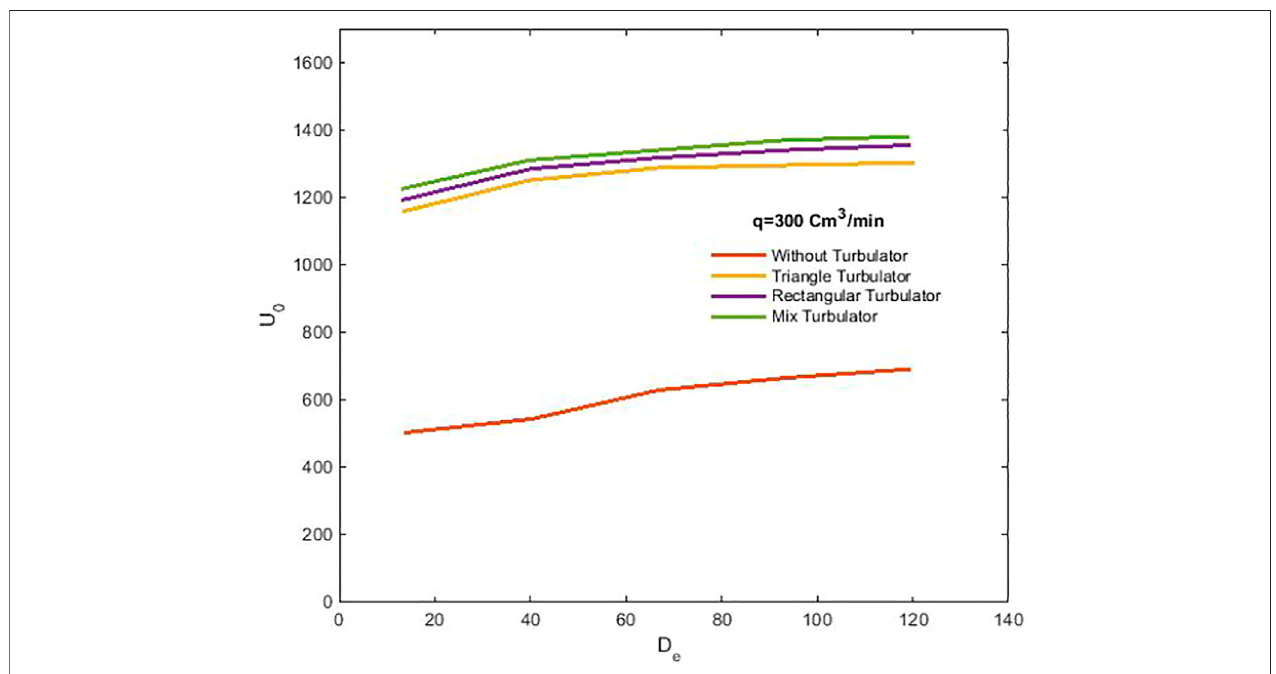
FIGURE 6 | The pressure loss comparison of the heat exchanger with and without Turbulator.